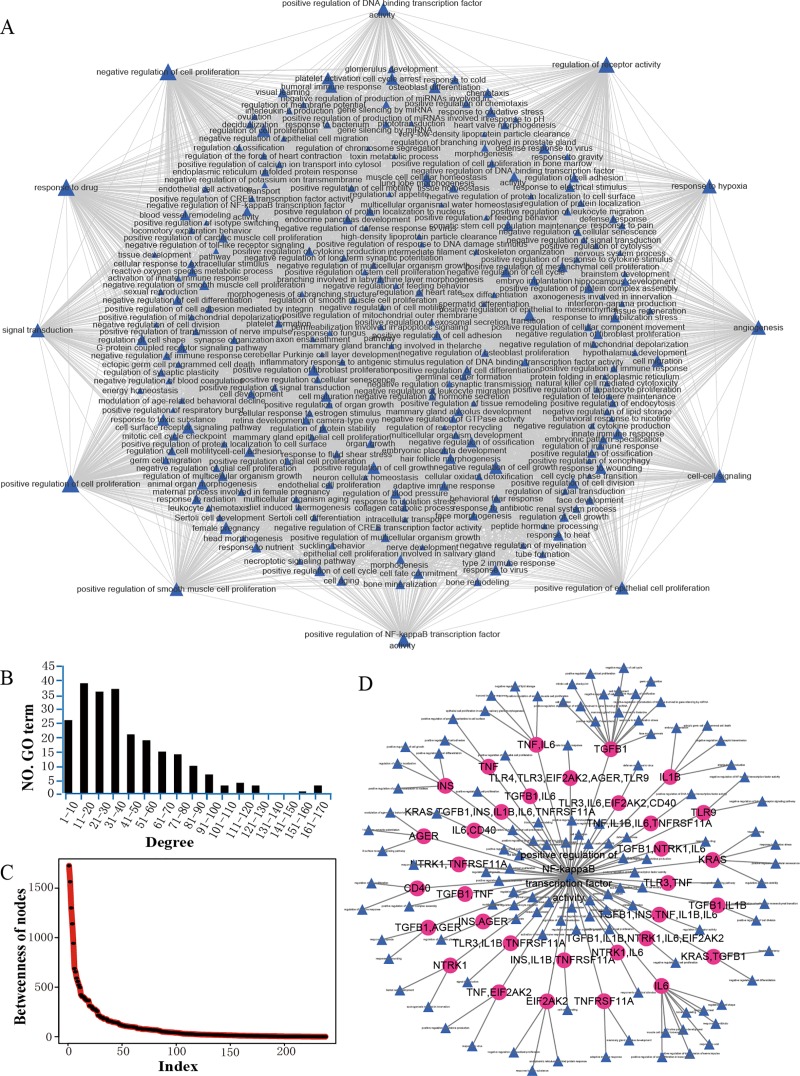
The associations among GO functions.GO function network (GOFN) in MG. Blue triangles represent GO functions; the size of the node represents the magnitude of the degree; the edge represents the connection between the two GO functions. (B) Degree distribution of all the nodes in the GOFN. (C) Node betweenness in the GOFN. (D) The dissection between the GO function for the positive regulation of NF-kappaB transcription factor activity and its connected GO functions. Blue triangles represent GO functions; purple circles represent MG risk genes; the interaction of two GO functions via MG risk genes is shown in the figure.